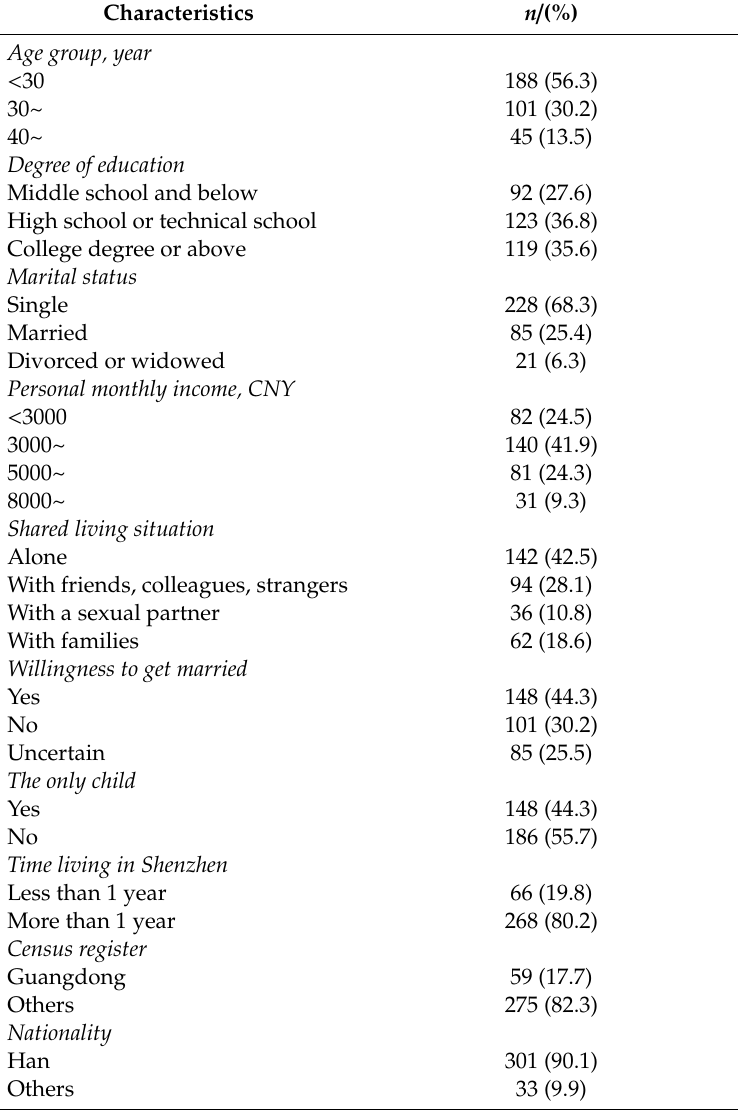
Table 1. Social demographics of the participants ( n =